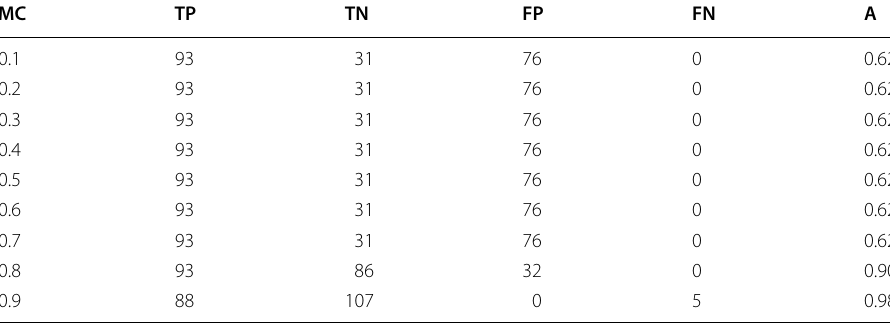
Table 17 Accuracy for the fuzzy ARL